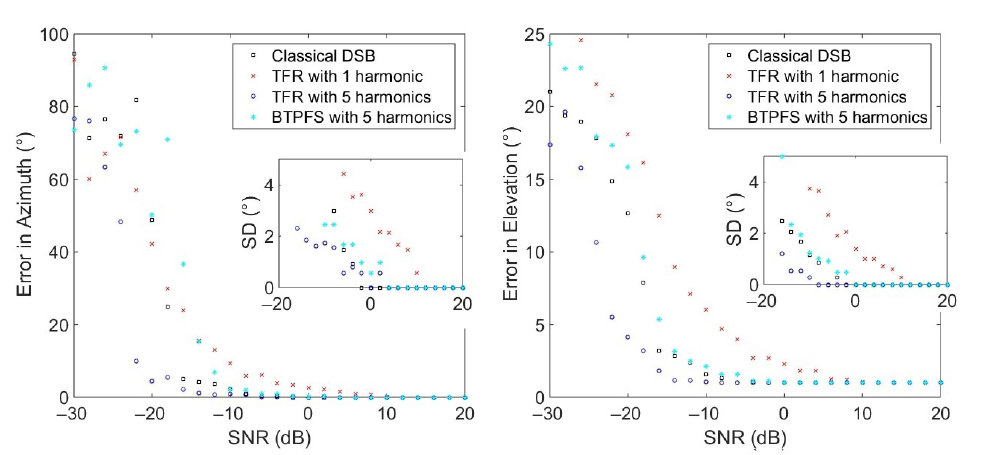
Figure 7. Evolution of the angle errors and standard deviations (SD) as a function of the SNR for the (0°, 45°) source with classical DSB, 1 harmonic considered in the TFR, 5 harmonics in the TFR and in the